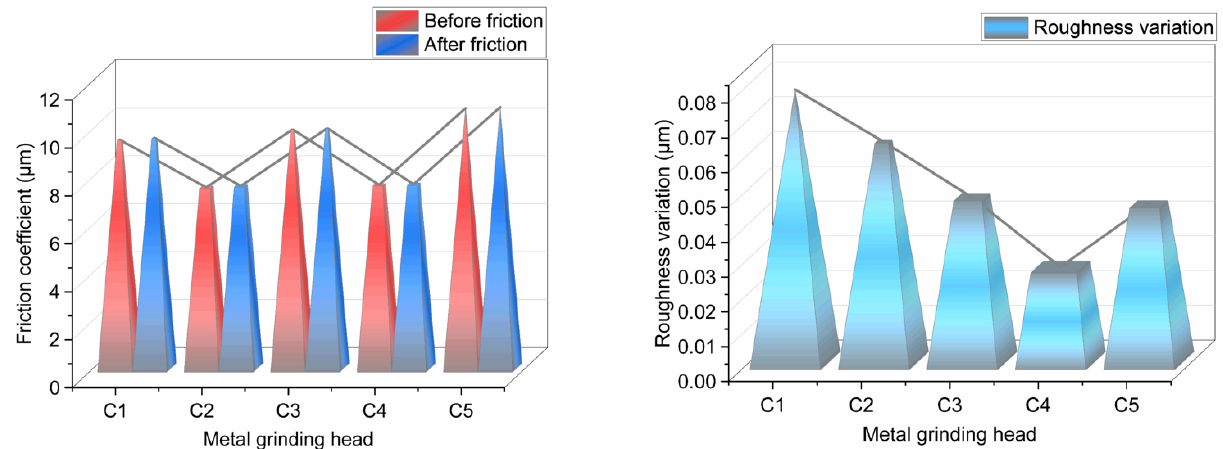
Figure 16. Metal surface roughness before and after friction. Figure 16 indicates that the roughness of the metal surface increased after friction.